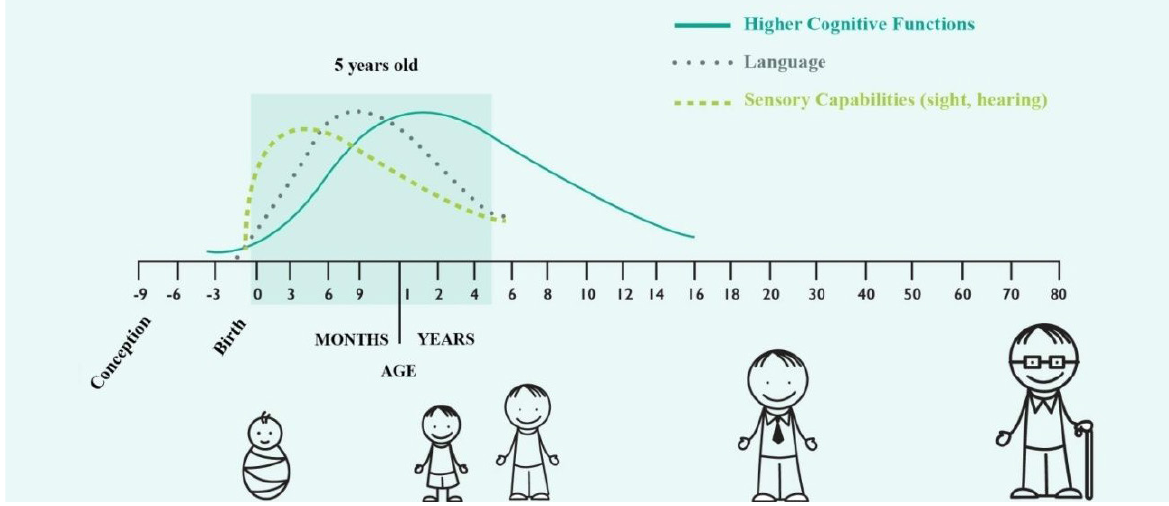
Figure 1. Formation of new